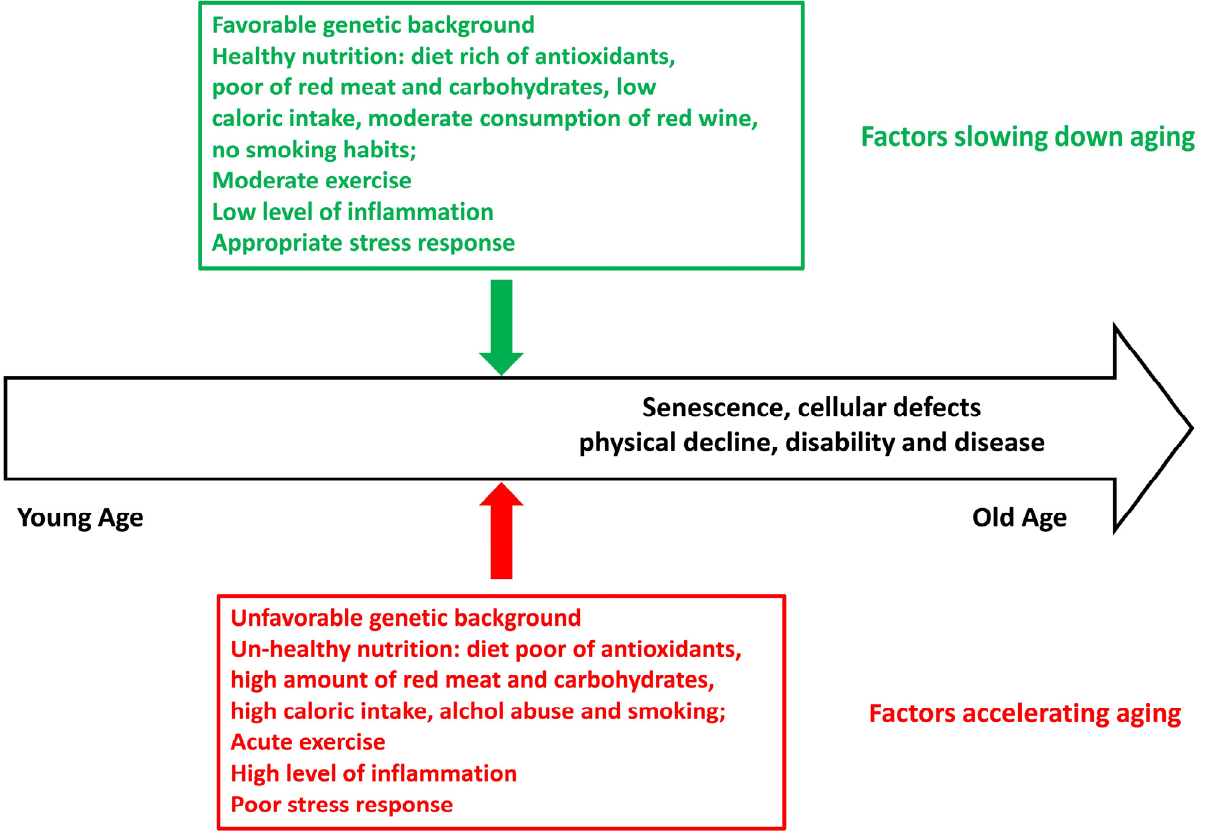
Figure 1. Schematic representation of the different factors modulating the oxidative stress response and influencing healthy aging/longevity. In green is indicated a possible protective profile able to slow down aging and reduce the consequences of impaired homeostasis (senescence, cellular defects, physical decline and disease). On the contrary, a possible detrimental profile for oxidative stress response is indicated in